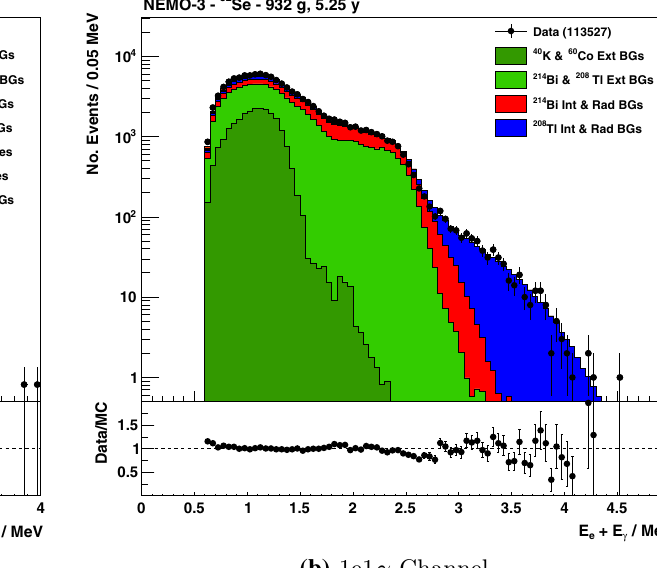
the highest energies are a result of external neutron flux. They do not contribute significantly to any other channel. b Distribution of the sum of electron and γ -ray energies for events selected in the 1e1 γ channel comparing data to the MC prediction. Below 2 . 5MeV the distributions are mainly composed of events from the external γ -ray flux. Above this energy the spectrum contains events from contamination of the source foil with 208 Tl